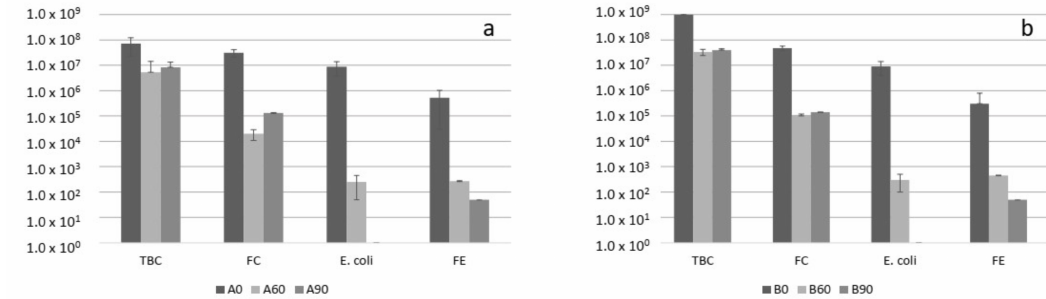
Figure 8. Microbiological indicator values of compost pile A ( a ) and B ( b ) during the composting process. Data are expressed in CFU/g. TBC = total bacterial count, FC = fecal coliforms, FE = fecal enterococci.